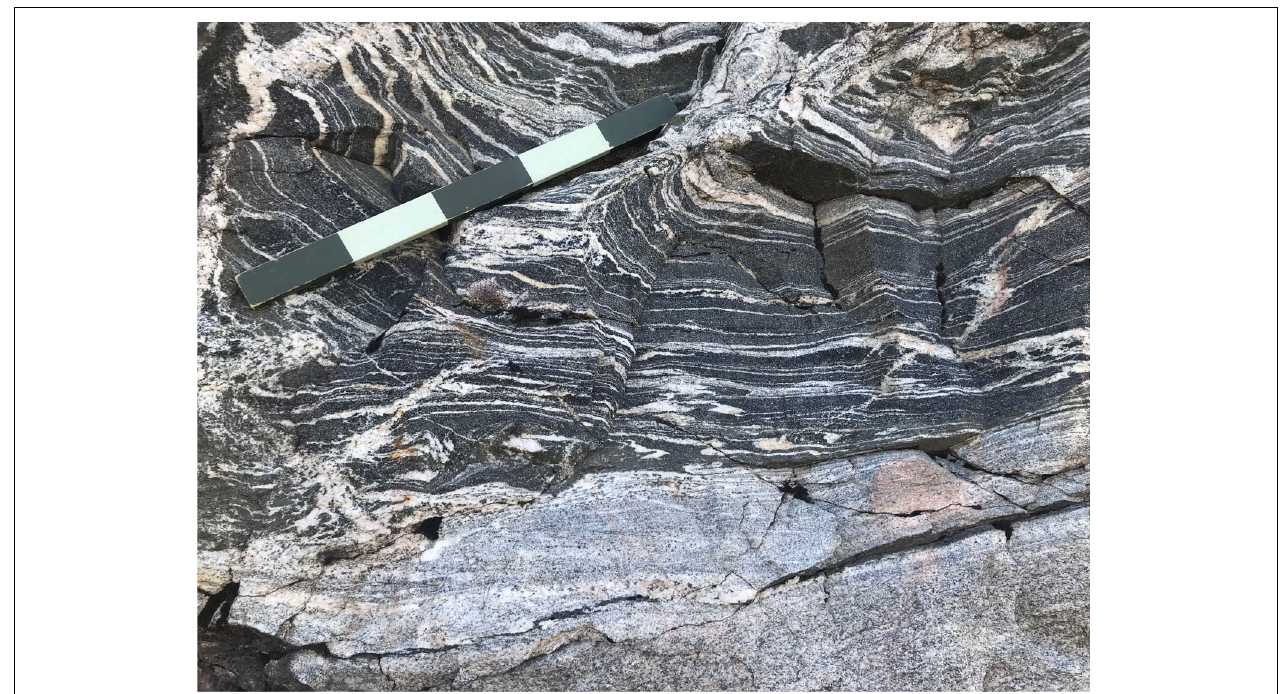
FIGURE 7 | Net-structured metatexite (upper part of the photo), Kvaløya, northern Norway, West Troms Basement Complex (same outcrop as in Figure 5 ). Layer-parallel leucosomes connecting to discordant veinlets indicate melting during folding and represent the remains of outward melt channels. The lack of melanocratic borders in crosscutting leucosomes suggest that they did not attract melt from their hosts but are conduits for the migration of melt out of the source region. Length of scale 50 cm.